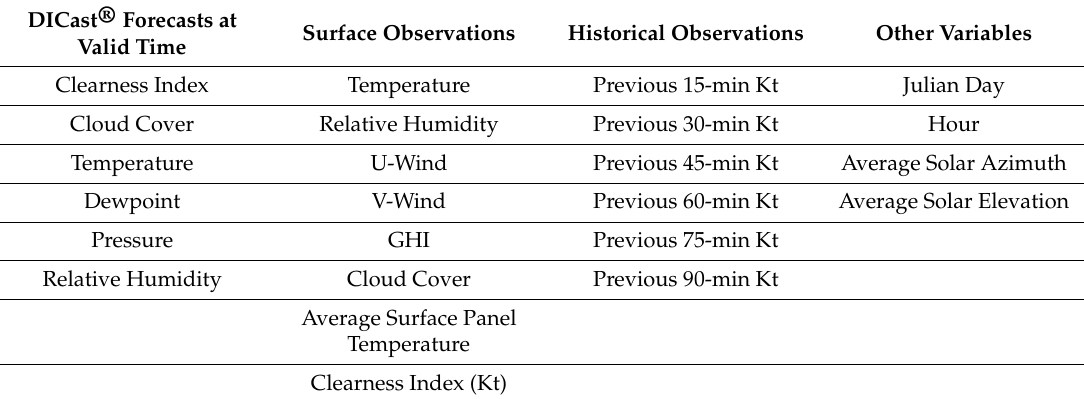
Table 1. Predictor variables for the machine learning